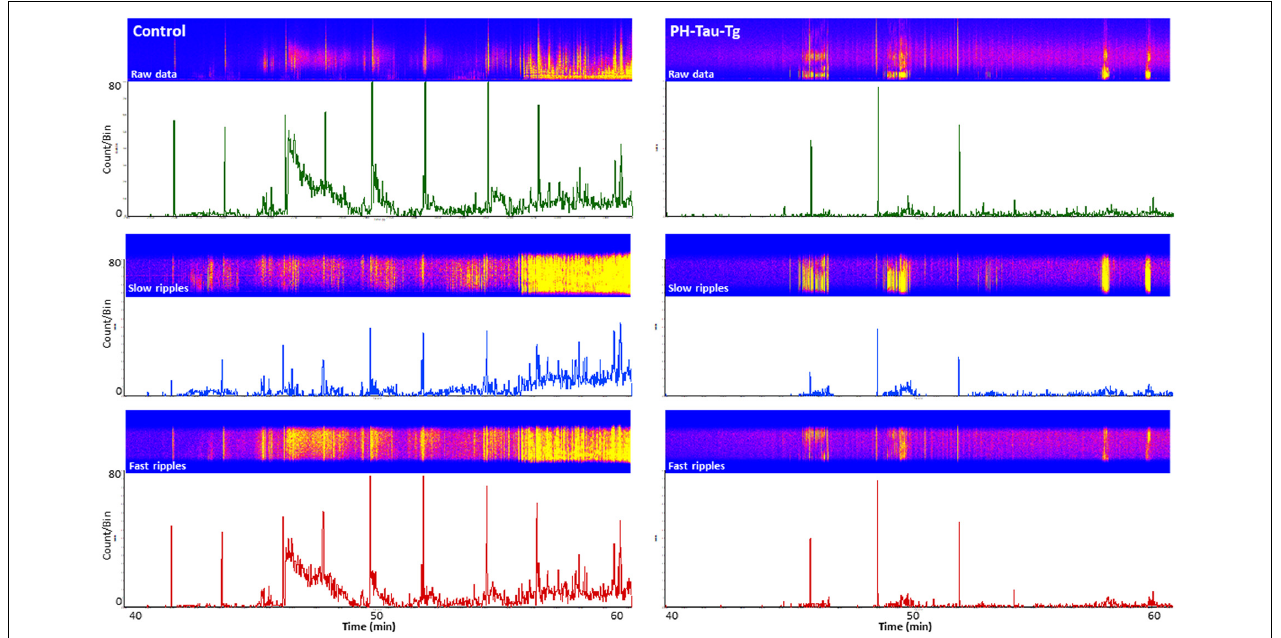
FIGURE 3 | Selective enhancement of cortical ripples after KA injections. Firing rate analysis with a detection threshold of 100 µ v shows a significant increase after KA injection in controls (left) and a drastic decrease in PH-Tau-Tg mice (right) . Spike histograms of filtered frequencies show a significant increase in both slow ripples [ F (1) = 81.48, p < 0.001] (125–250 Hz) and fast ripples F (1) = 9.95, p < 0.001 (250–500 Hz) post KA injection in controls in presence of insulin (left panel). Insulin injection led to a significant suppression of both HFOs post KA injection. Detection threshold for slow ripples and fast ripples were 0.02 and 0.04 mv, respectively. Bin size was set to 1 s. The power density of field potentials and filtered frequencies were converted into heat maps and shown on top of the respective spike histogram (left, Controls and right, PH-Tau-Tg mice). Heat maps are representatives of a control mouse and PH-Tau-Tg mouse. Spike histograms are obtained from pooled data of controls ( n = 3) and PH-Tg mice ( n = 3)